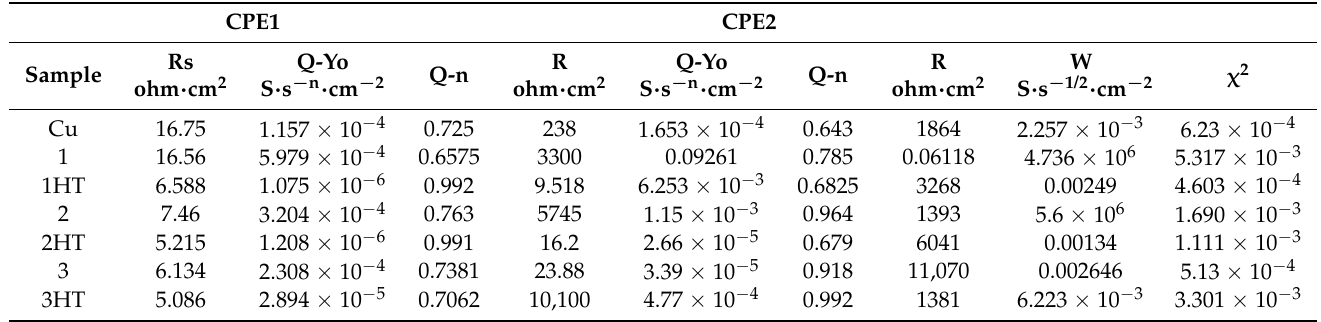
Table 2. Electrochemical parameters of the uncoated and coated electrodes as-deposited and heat- treated, in a synthetic seawater